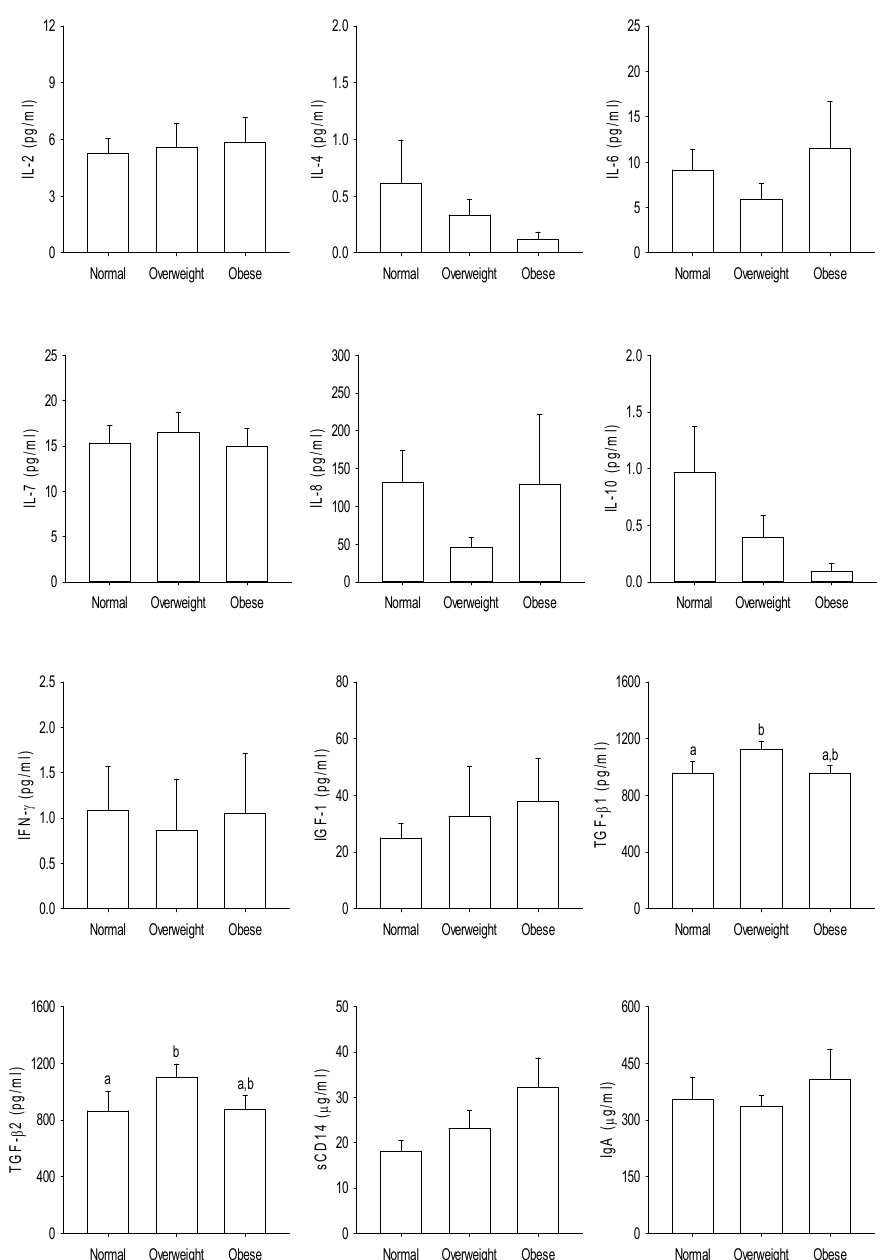
Figure 6. Immune-related proteins in the mother’s breast milk categorized according to the body mass index outlined by the Ministry of Health, New Zealand. Data expressed as the mean ± standard error of the mean. Mean values with a di ff erent letter di ff er significantly, p < 0.05. IL—interleukin, IFN—interferon, IGF—insulin-like growth factor, TGF—transforming growth factor, sCD—soluble cluster of di ff erentiation, and Ig—immunoglobulin.